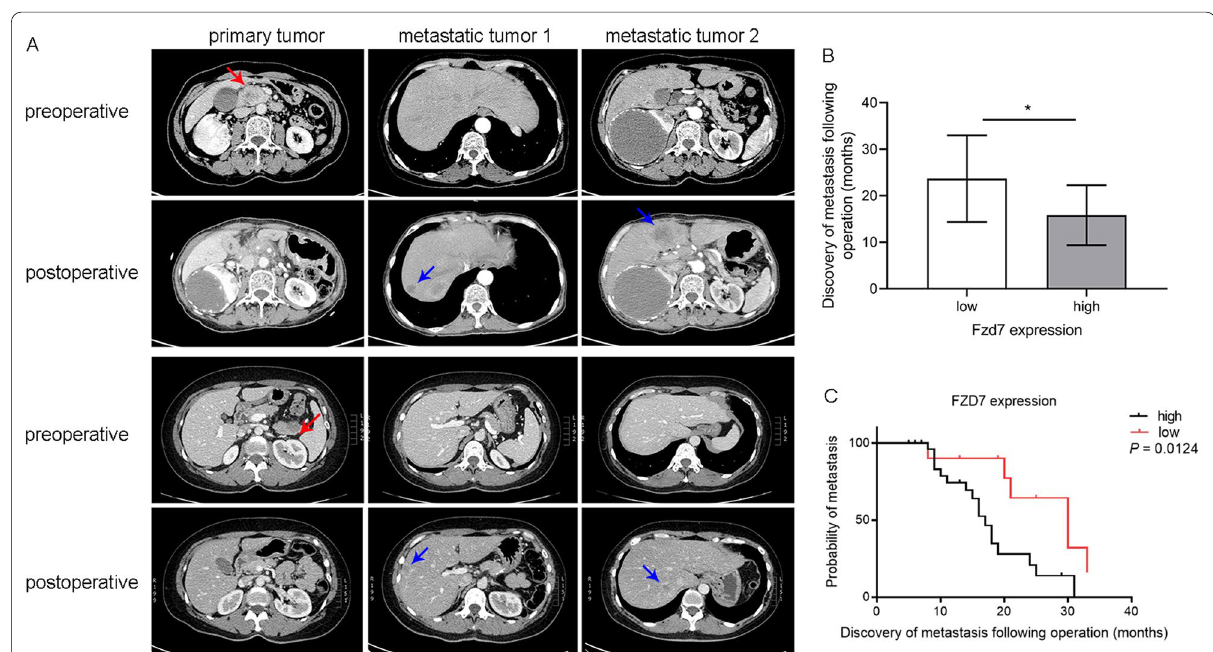
Fig. 2 Postoperative hepatic metastasis was confirmed by enhanced CT detection, red arrow tagging primary lesion, blue arrow tagging metastatic tumor ( A ); follow-up assay observed that the mean time of hepatic metastasis was 23.7 9.3 months for 17 of 31 pancreatic cancer patients with ± high FZD7 expression, while 15.8 6.4 months for 6 of 11 pancreatic cancer patients with low FZD7 expression, * P < 0.05, independent Student’s ± t-test ( B ); the monthly cumulative metastasis probability of the low FZD7 expression group was lower than that of the high FZD7 expression group, P < 0.05, Kaplan–Meier analysis ( C